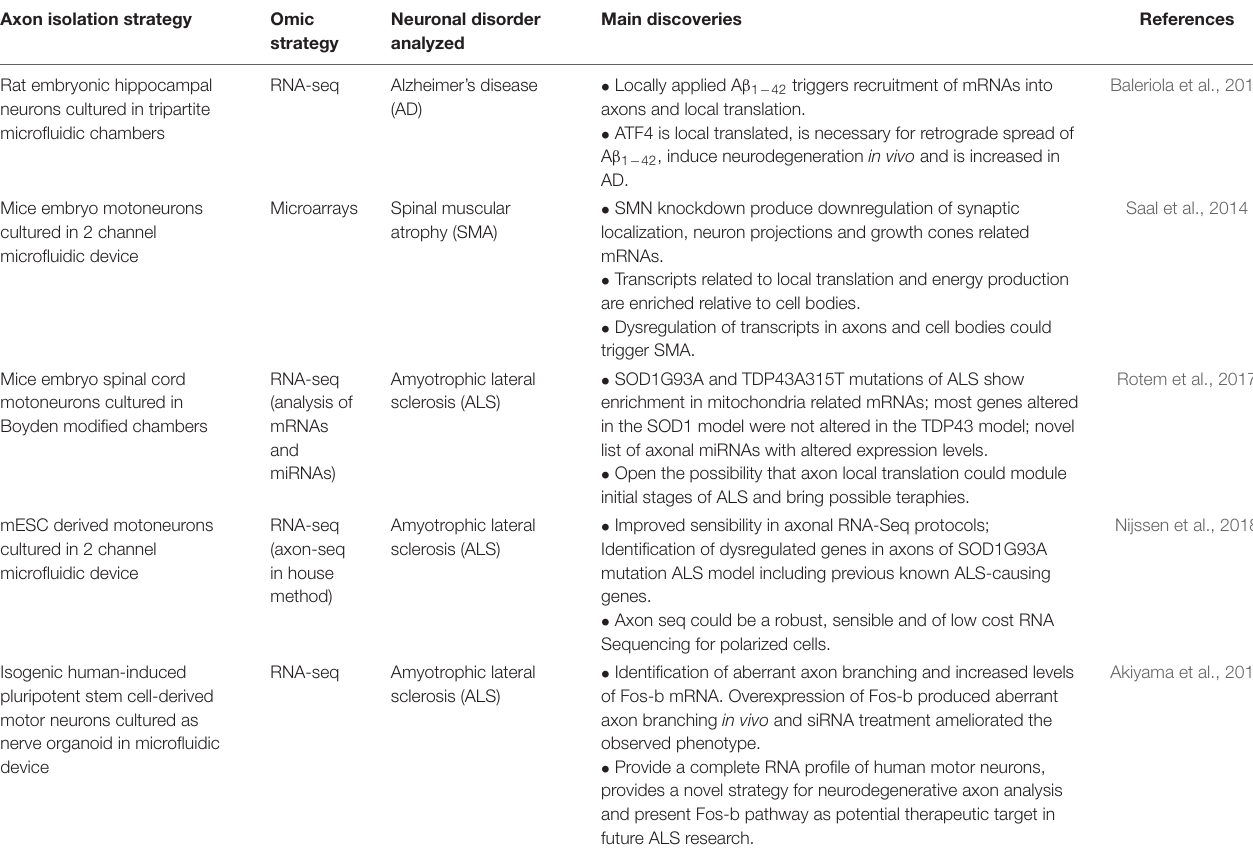
TABLE 3 | Summary of axonal omic approaches implemented for the study of neurodegenerative